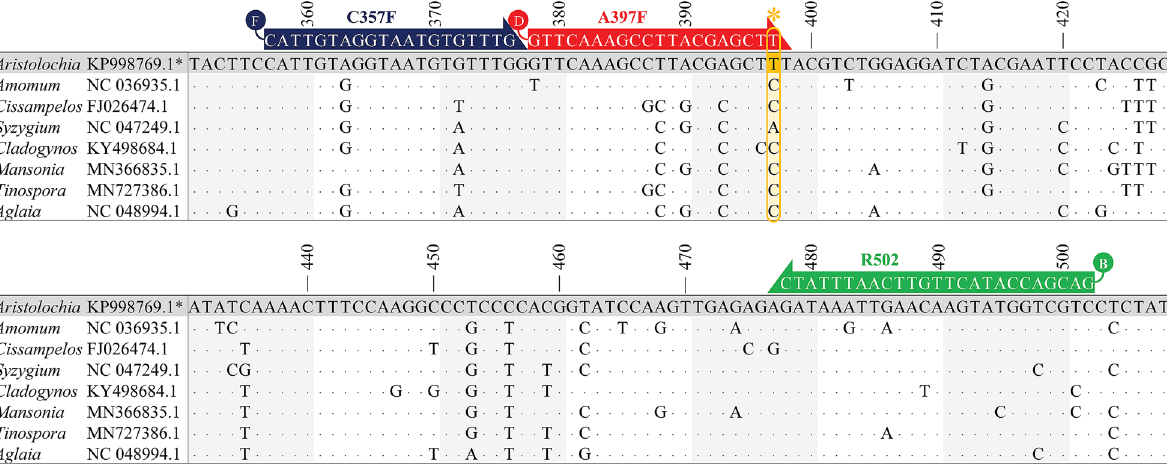
Figure 3. The primer design for the detection of Aristolochia spp. by PCR - LFA on a partial rbc L gene alignment. Selected plant species are shown in the alignment. Primers A397F (red) and R502 (green) were used for amplification of the internal control amplicon. Primer C357F (blue and R502 (green) was used for amplification of the Aristolochia -specific PCR amplicon. At the 5’-end of C357F, R502 and A397F primers were labeled with FAM (F), biotin (B) and DIG (D), respectively. The yellow box and asterisk present the nucleotide signature of the Aristolochia plant. Consensus sequences are indicated with dots. The altered bases indicate the sequence